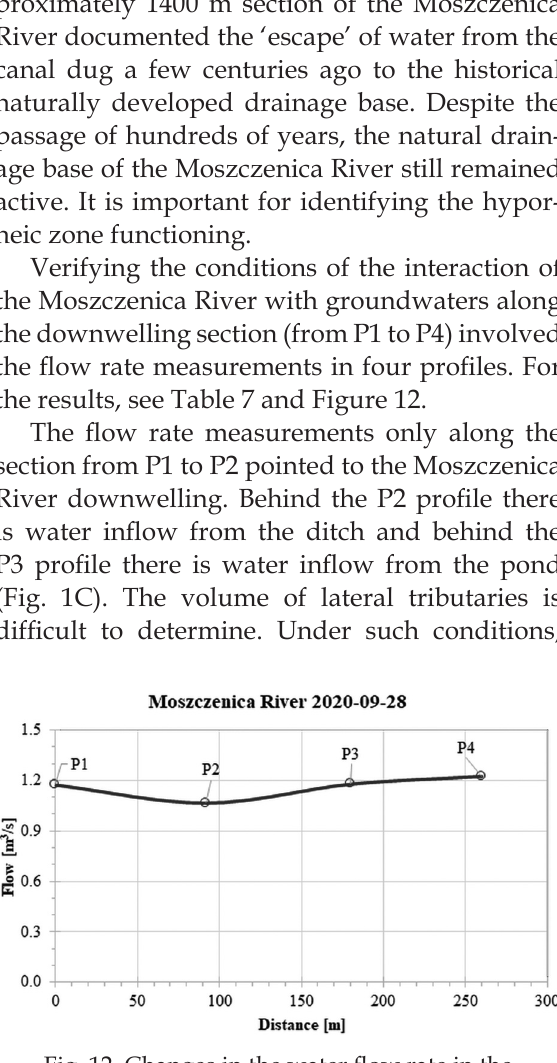
Fig. 12. Changes in the water flow rate in the Moszczenica River along the downwelling